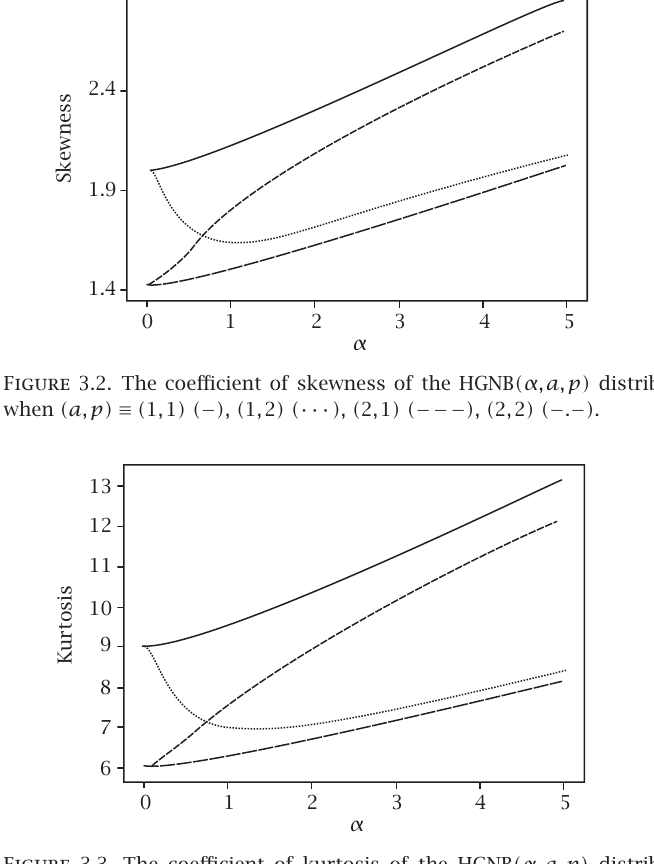
Figure 3.3 . The coefficient of kurtosis of the HGNB (α,a,p) distribution when (a,p) ≡ ( 1 , 1 ) ( − ) , ( 1 , 2 ) ( ··· ) , ( 2 , 1 ) ( −−− ) , ( 2 , 2 ) ( − . − )